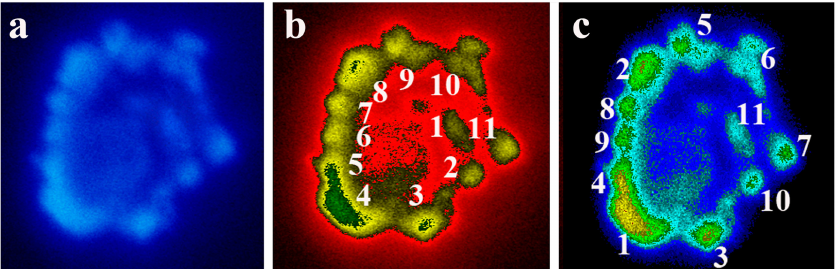
Figure 7. Semi-circular (not closed) arrangement of pre-chromosomes in nuclei of CHO K1 cells synchronized at the end of S-phase (3.5–4.0 C). CHO cells at the end of S phase stages in S phase were obtained by centrifugal elutriation. Chromatin Image Analysis of condensing chromosomes. ( a ) The semicircular arrangement of chromosomes in a CHO-K1 nucleus. The linear arrangement of chromosomes seen after the DAPI staining of nuclear material. ( b ) Chromatin image analysis: Numbering of linearly arranged chromosomes starting at the chromosome closest to the largest (number 1) chromosome. ( c ) Numbering based on chromosome size. Size of nucleus, 5 µ m each. Modified with permission from Ref. [30]. Copyright year 2009, Springer, Dordrecht. Figure 3.16 of this